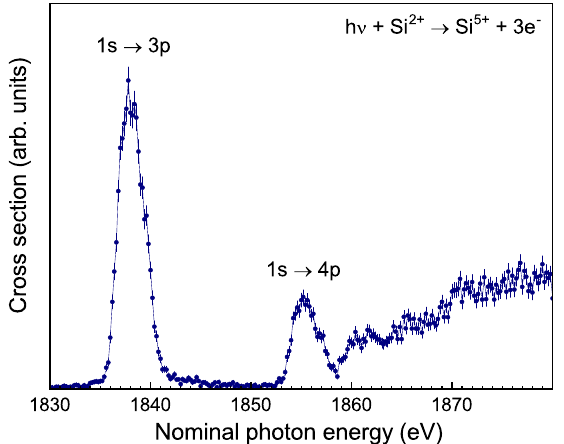
Figure 7. Experimental cross section for K -shell triple ionization of Si 2 + . These preliminary data from [86] are not on an absolute cross section scale, and the photon energy scale has not been calibrated,